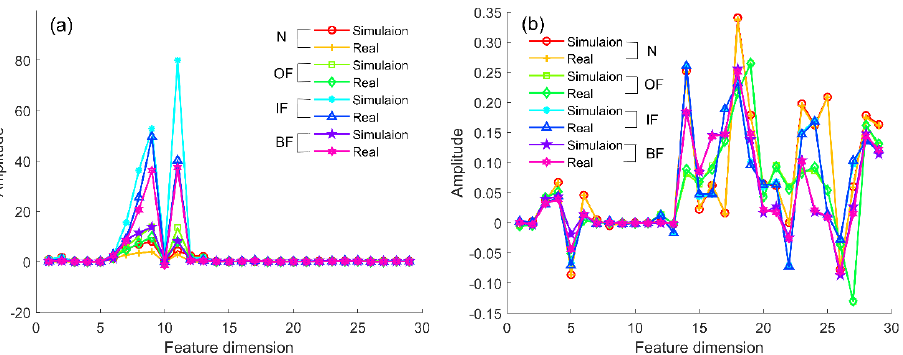
Figure 9. Distribution of features under four fault types before and after cDNAP: ( a ) before cDNAP; ( b ) after cDNAP.